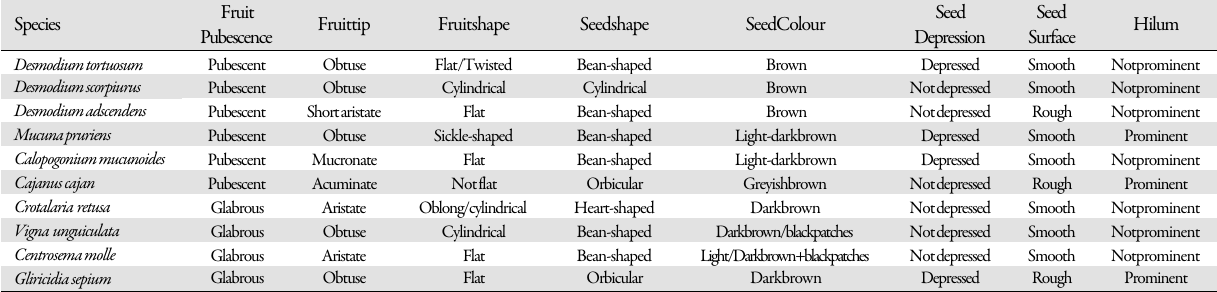
Table 1. Summary of qualitative morphological characters of the species of the subfamily Papilionoideae studied (Contd) Species